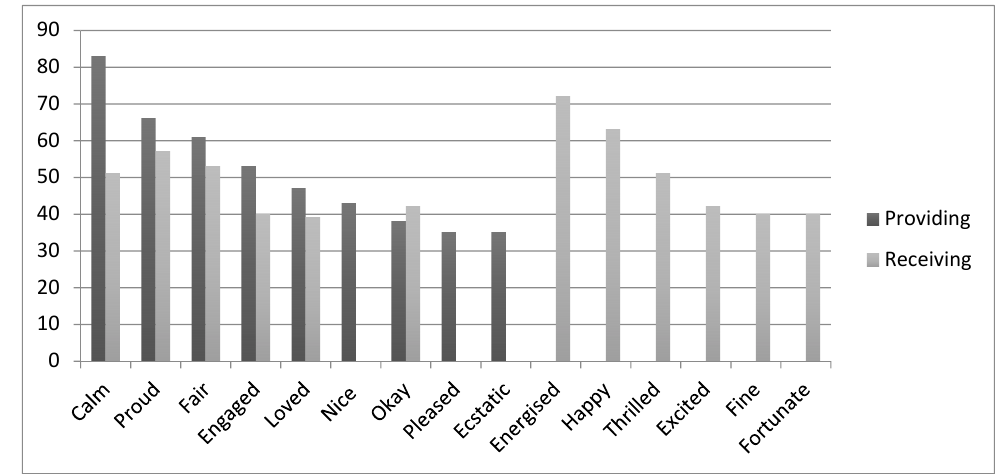
Figure 2. Emotional attributes associated with providing versus receiving excellent customer service (Y-axis shows the percentage of people significantly associating primes with the receipt and provision of excellent service).